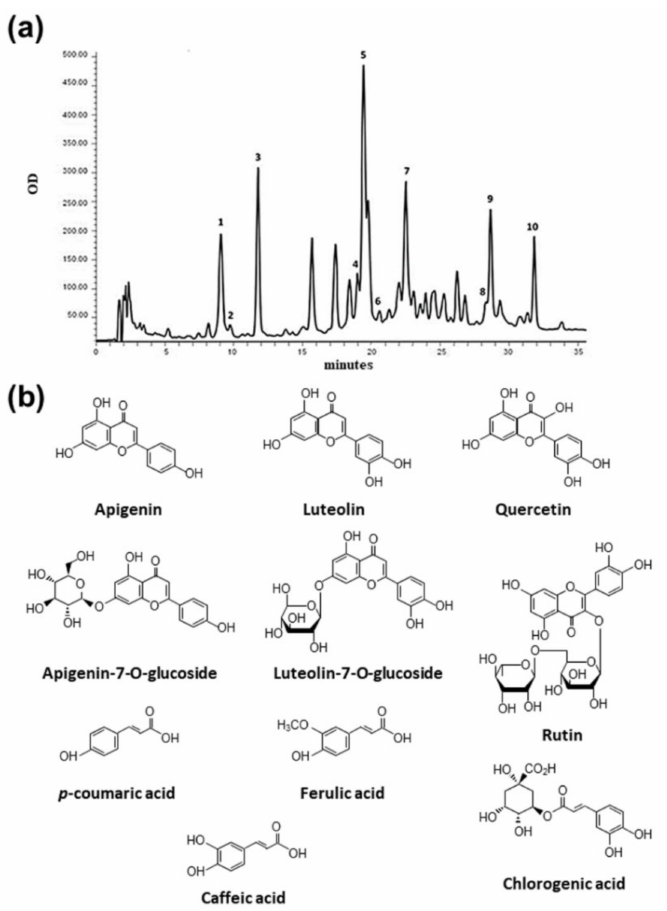
Figure 4. Chromatogram of 3F sample obtained with DAD detector set at 260 nm ( a ) and chemical structure of identified compounds ( b ). Identified peaks: 1. chlorogenic acid (9.07 min), 2. caffeic acid (9.74 min), 3. p -coumaric acid (11.77 min), 4. ferulic acid (19.01 min), 5. luteolin-7-O-glucoside (19.77 min), 6. rutin (20.60 min), 7. apigenin-7-O-glucoside (22.52 min), 8. quercetin (28.37 min), 9. luteolin (28.70 min), and 10. apigenin (31.89